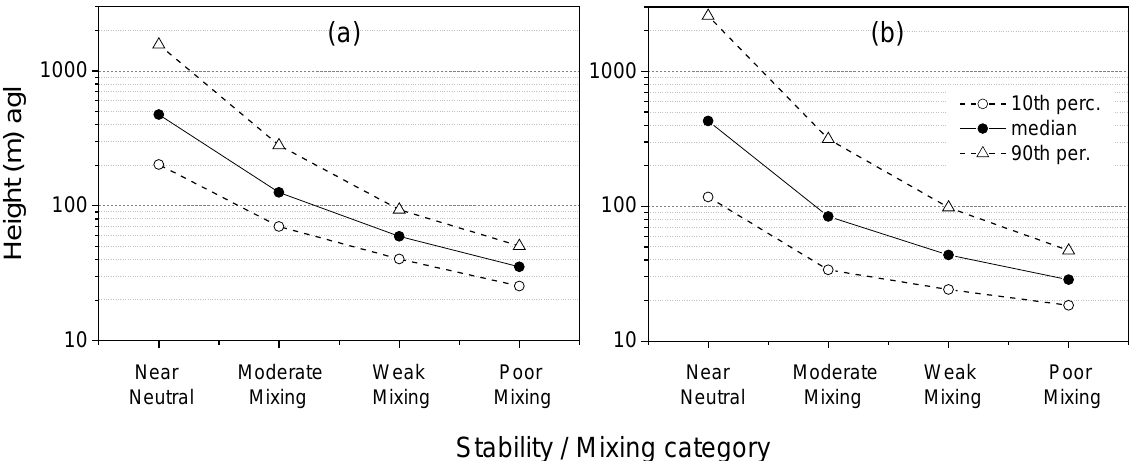
Figure 11. Distributions of estimated nocturnal mixing depth as a function of radon-derived stability class for (a) accumulated mixing heights ( h a ) , and (b) equivalent mixing heights ( h e ) .